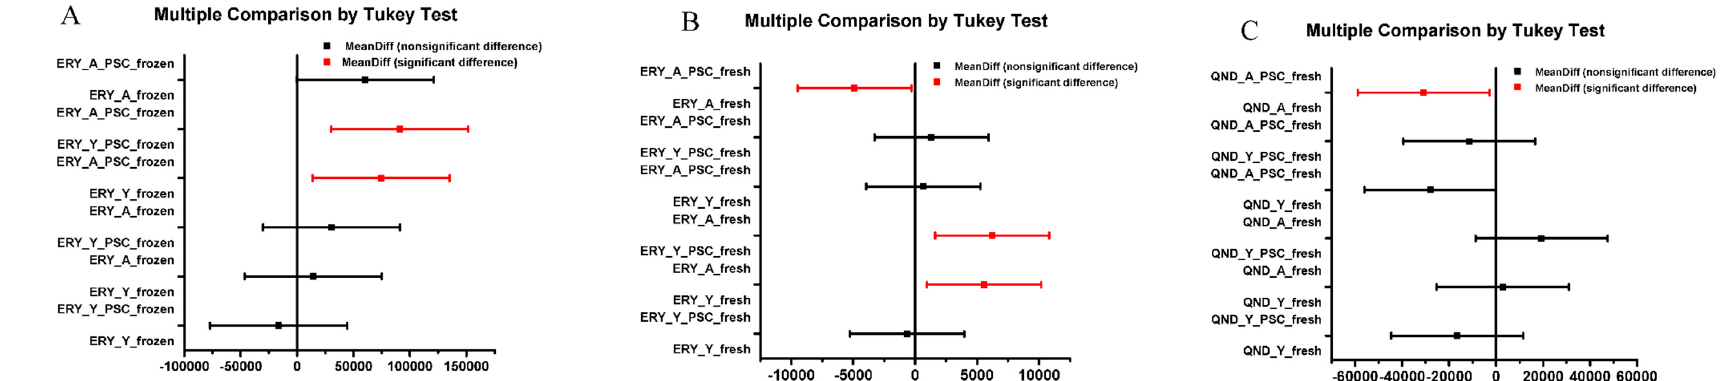
Figure 6. Multiple comparison of means of area under the concentration-time curves (AUC-s) of P-gp substrate penetration across the dermal barrier by Tukey test. (Panel ( A )) Aged and young, frozen rat skin samples were compared for erythromycin (ERY) penetration in the presence or absence of PSC-833 pretreatment. (Panel ( B )) Aged and young, freshly prepared rat skin samples were compared for erythromycin (ERY) penetration in the presence or absence of PSC-833 pretreatment. (Panel ( C )) Aged and young, freshly prepared rat skin samples were compared for quinidine (QND) penetration in the presence or absence of PSC-833 pretreatment.